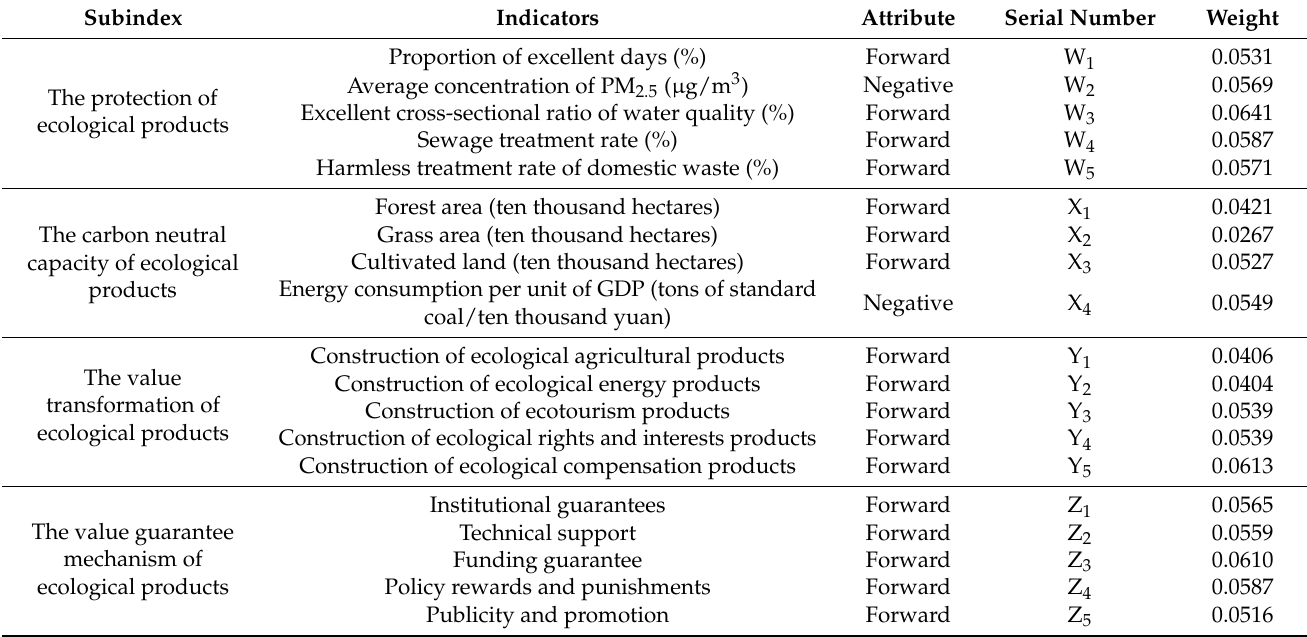
Table 6. Evaluation index system of the